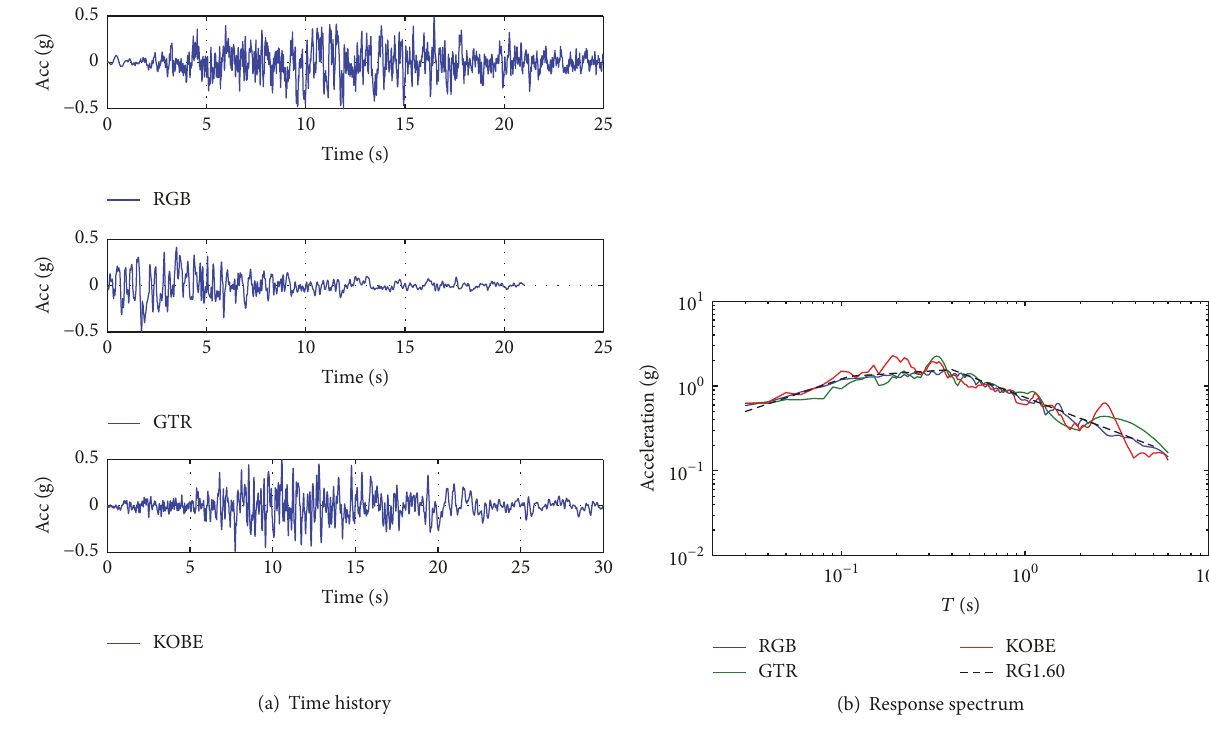
(b) Response spectrum